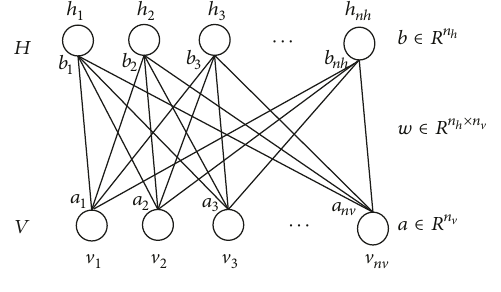
Figure 2: The structure of RBM.